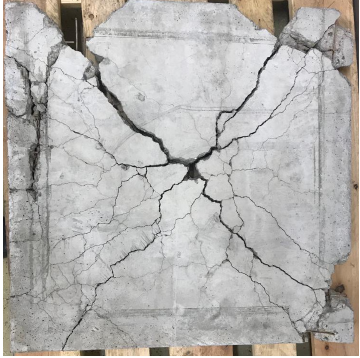
Figure 1. Cracked reinforced concrete plate (70 × 70 cm 2